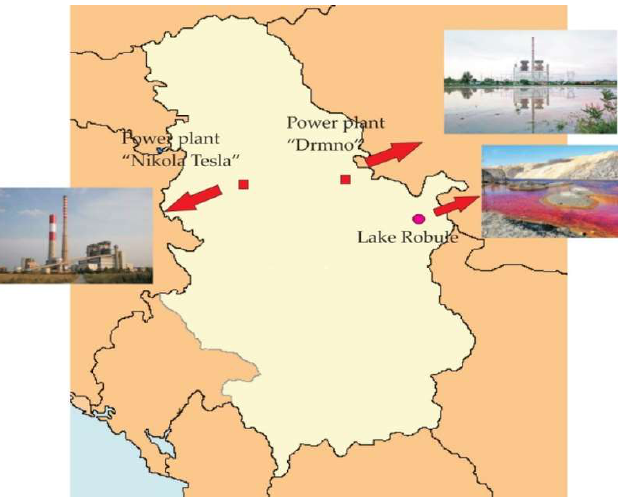
Figure 1. A schematic geographic map of Serbia showing the locations of the Nikola Tesla and Drmno Thermal power plants, as well as Lake Robule. Thermal power plants, as well as Lake